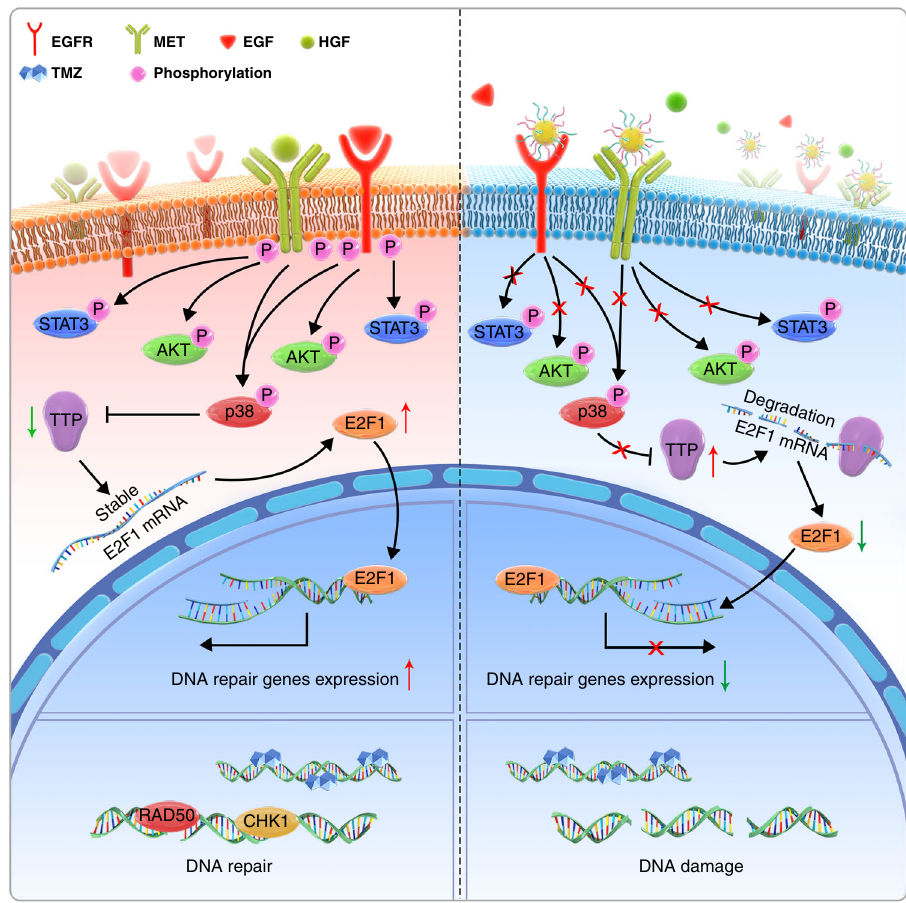
Fig. 7 The mechanistic scheme of a dual functionalized BIP-MPC-NP in temozolomide-resistant glioma. The mechanistic scheme of BIP-MPC-NP attenuating DNA damage repair to enhance TMZ sensitivity by simultaneously mitigating EGFR and MET activation in TMZ-resistant